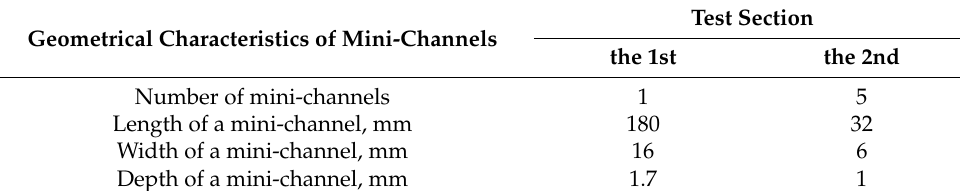
Table 1. Geometrical characteristics of mini-channels in the two test sections.